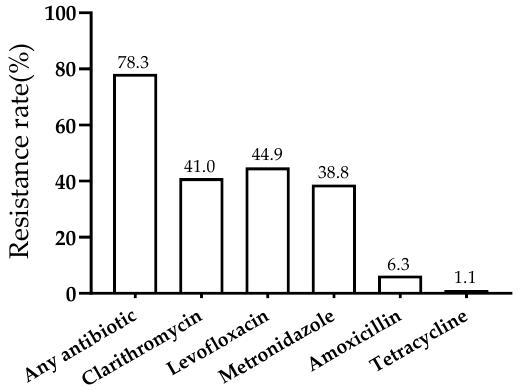
Figure 2. The resistance rate of H. pylori strains to Clarithromycin , Levofloxacin , Metronidazole , Amoxicillin , Tetracycline . The distribution of the H. pylori -resistant gene locus is shown in Table 3. The H. pylori resistance gene locus by the gene chip identified CLR resistance to be mainly at A2143G, accounting for 98.4% (186/189). Four mutation sites of gyrA gene were detected in 207 LVX-resistant strains, the most common was N87K, accounting for 63.3% (131/207), fol- lowed by D91N (14.5%, 30/207), D91G (14.5%, 30/207) and D91Y (7.7%, 16/207). MTZ re- sistance was mainly due to mutation at G616A of rdxA gene (100.0%, 179/179). Three mu- tation sites of PBP1 gene were detected in 29 AMX resistant strains, namely T556S (62.1%, 18/29), N562Y (34.5%, 10/29) and N562D (3.4%, 1/29). All five TET resistant strains had mutations in the AGA926-928TTC site of 16S rRNA gene (100.0%, 5/5). Table 3. Detection of H. pylori resistant gene locus by gene chip technology. Antibiotics